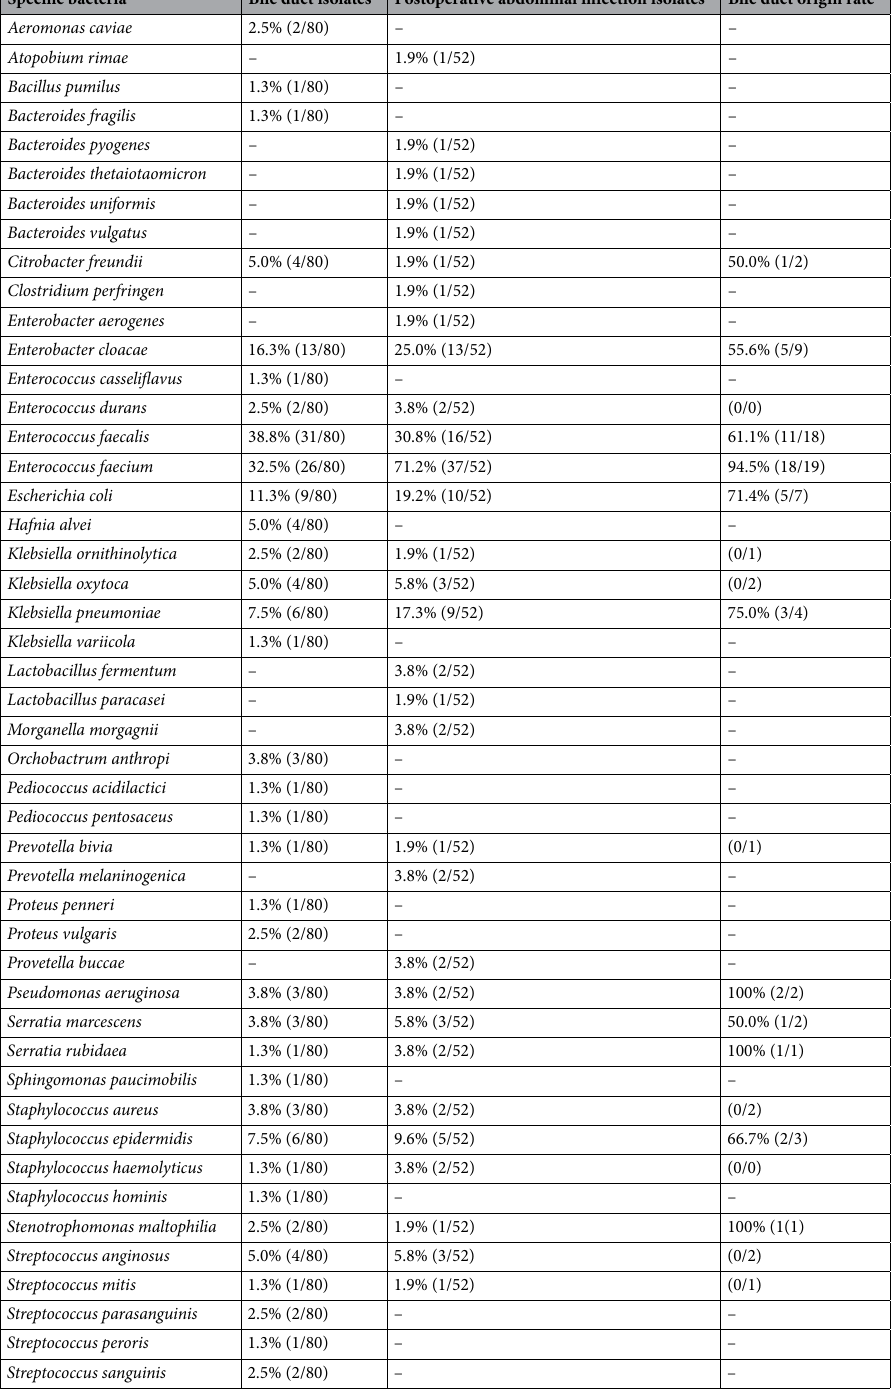
Table 6. Identified bacterial species causing the bile duct colonization or postoperative abdominal infections. The percentage of specific bacteria of the bacterial isolates in the bile ducts and postoperative abdominal infections are shown. The bile duct origin rate is defined as the probability of a specific bacteria causing postoperative abdominal infection to already have colonized the bile ducts prior to